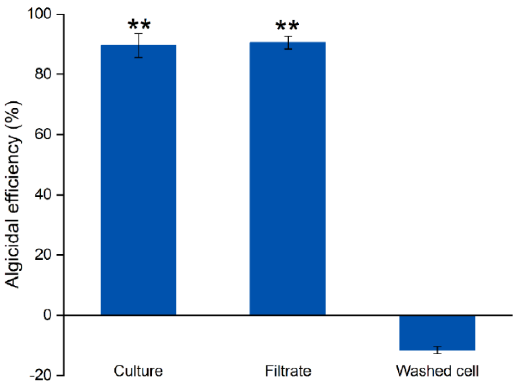
Figure 2. The algicidal efficiency of the culture, filtrate, and washed cell and of Paenibacillus sp. SJ-73 against M. aeruginosa PCC 7806 after 7 days’ treatment. Bars represent the standard errors of the means for triplicate. Significant differences are shown by asterisks: **, p <